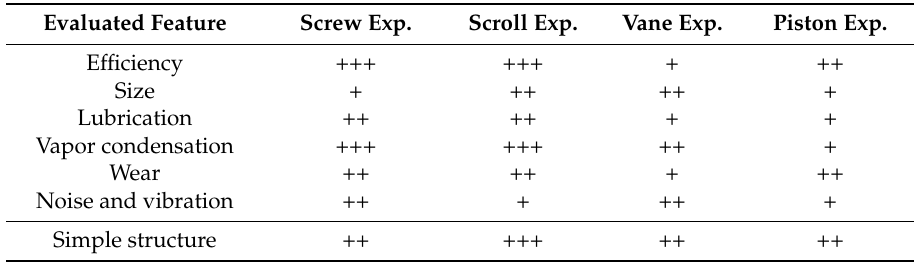
Table 1. Comparison of volumetric expanders (+: OK; ++: good; +++: very good) from [38]. Evaluated Feature Screw Exp. Scroll Exp. Vane Exp. Piston Exp. Efficiency +++